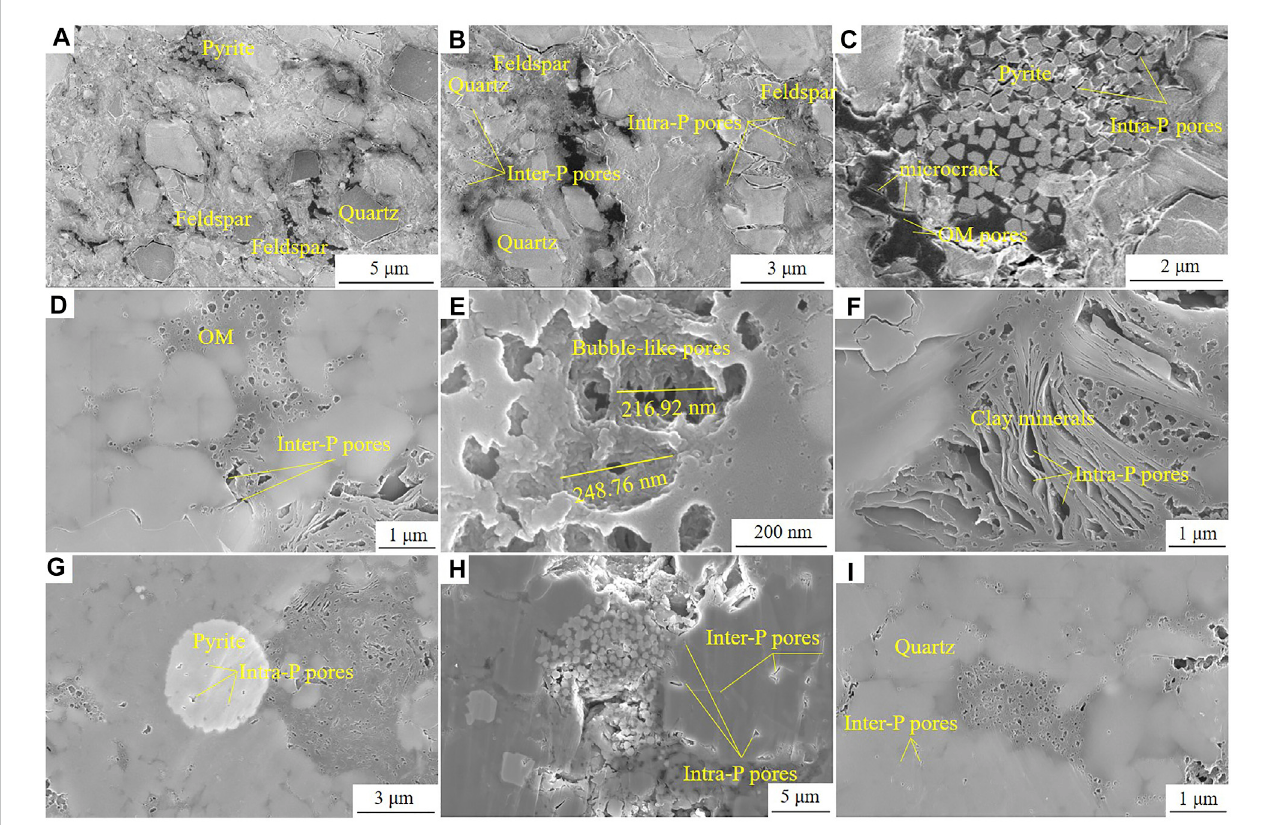
FIGURE 2 Poretypes intheLongmaxi andQiongzhusishalesfrom wellsMS#1andCS#1. (A,B) OMiscloselyassociated with mineralslikepyrite and quartz; (C) OM isdeveloped within pyrite; (D) OM pores; (E) bubble-likeOM pores; (F) OM pores developed inclay minerals; (G) intra-P pores developed inpyrite; (H) inter-P pores and intra-P pores; (I) intra-P pores within